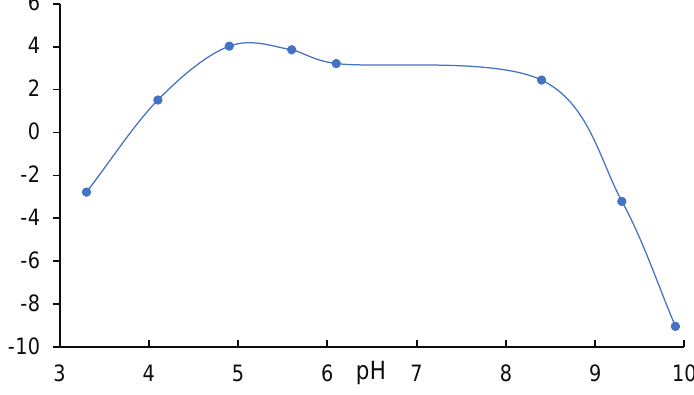
Figure 4. (BC/nTiO 2 ) P surface charge at various pH levels.